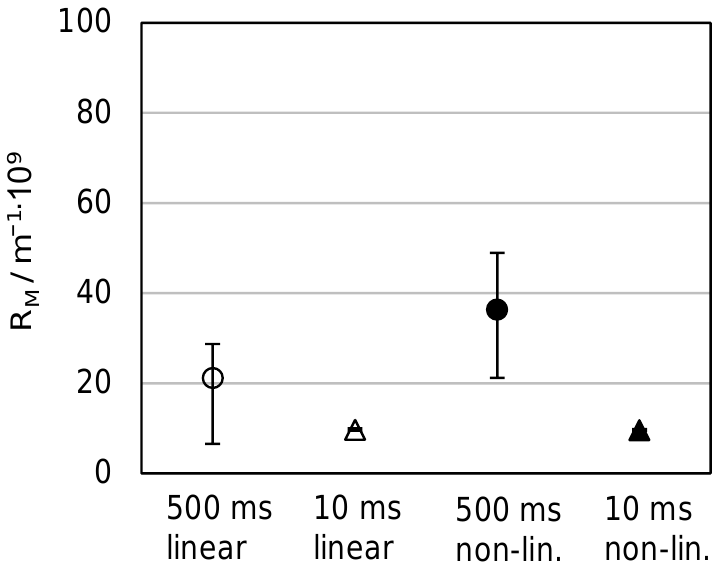
Figure 11. Effect on the filter medium resistance. Nonwoven measured with 25 m% PCC at 0.8 bar.